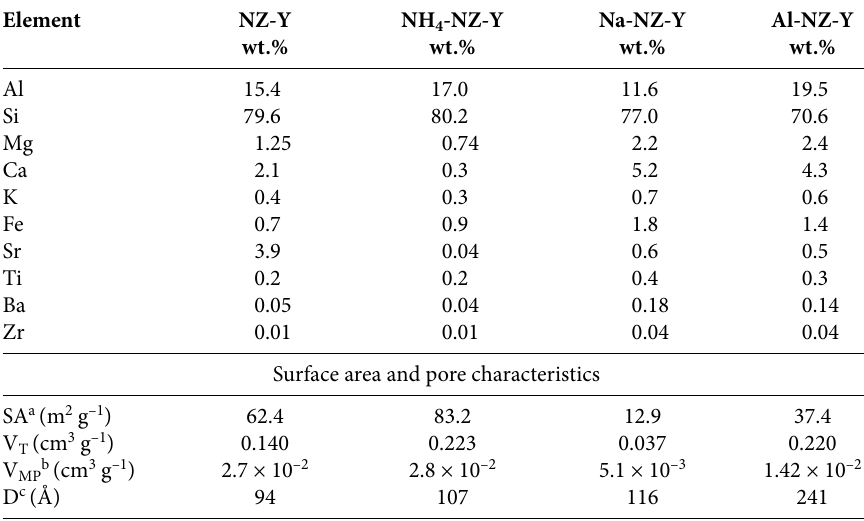
Table 1. The composition, surface area and pore characteristics of natural and modified zeolites. Element NZ-Y